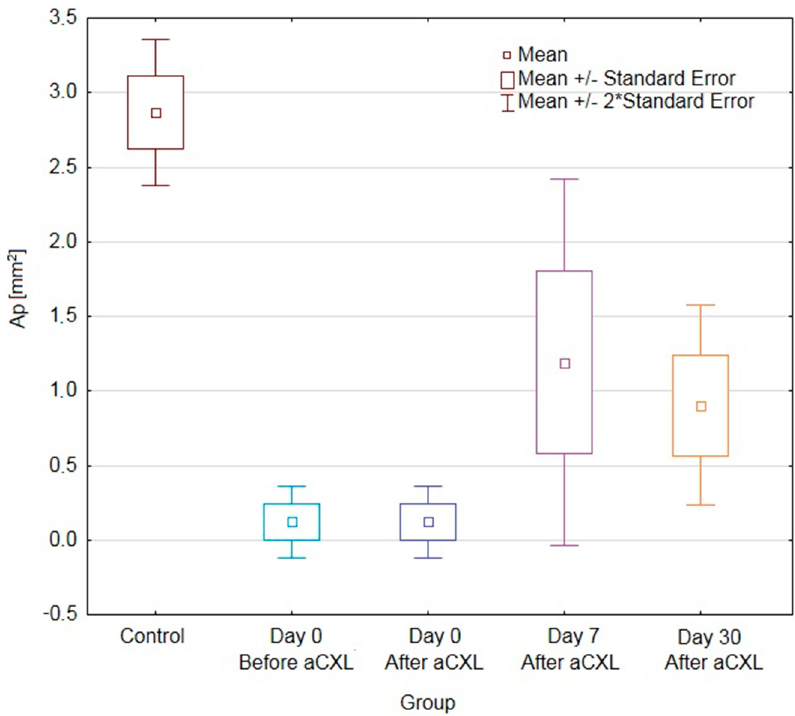
Figure 3. Box-and-whiskers plot of conjunctival ultraviolet autofluorescence (CUVAF) nasal and temporal perilimbal area (ApN + T) measurements in keratoconical eyes undergoing accelerated corneal cross-linking (aCXL) procedure and untreated keratoconical eyes as well as the eyes of control group patients. Abbreviations: CUVAF, conjunctival ultraviolet autofluorescence; ApN + T, nasal and temporal perilimbal conjunctival autofluorescence area; aCXL, accelerated corneal